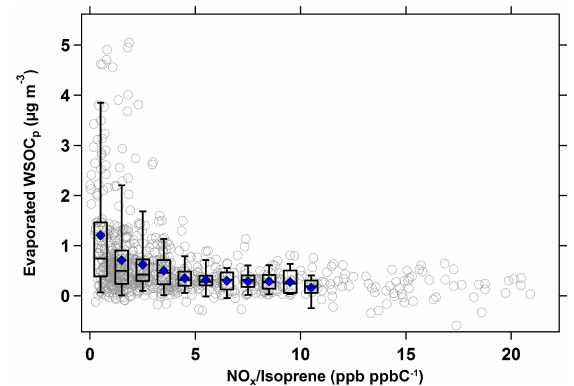
Figure 4. Median evaporated WSOC p concentrations as a func- tion of isoprene concentrations (ppbC or nmolCmol − 1 ) at different evaporated WSOC p time lags during the summer. Scatter and box plots showing individual data are presented in Fig. S6.